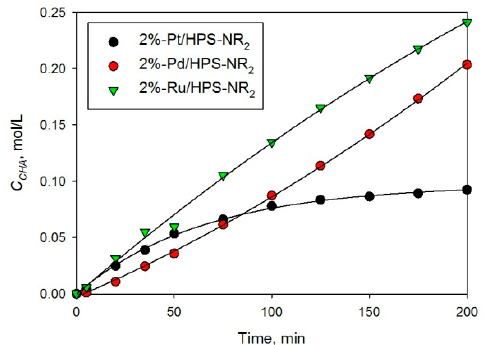
Table 2. Data of catalytic testing of HPS-based catalysts in hydrogenation of substituted aromatics.